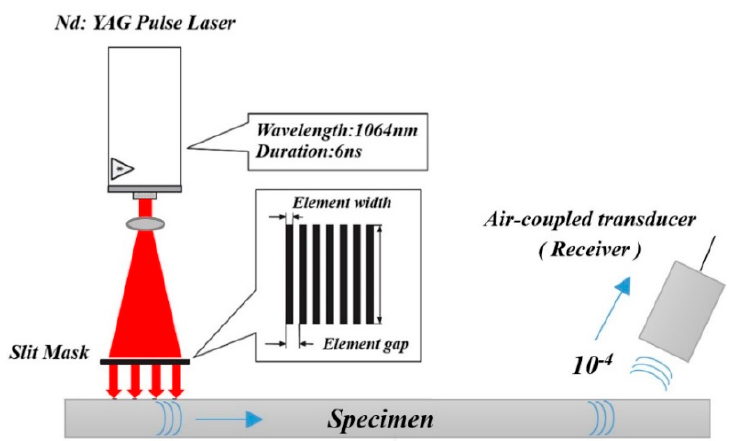
Figure 9. Improved transmission using a laser source. Values shown are approximate fractions of the original energy.